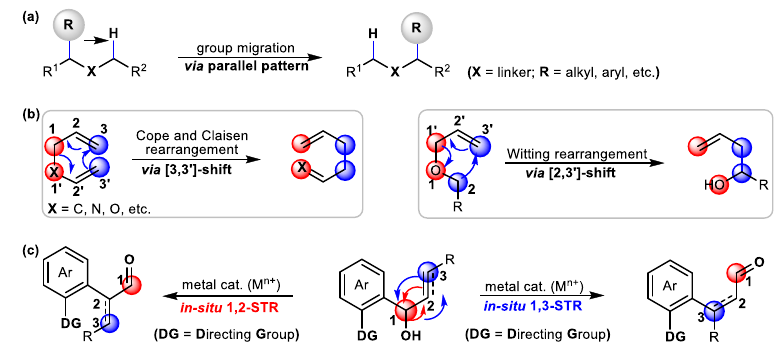
Fig.1|Strategiestoaccessmolecularskeletonrearrangement.a Thetraditional migratory patterns in Smiles, semi-pinacol, Beckmann, and Wolff rearrangements. b The sigmatropic shift in the Cope and Claisen rearrangement and the Witting